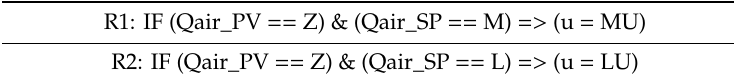
Table 14. The third version of the